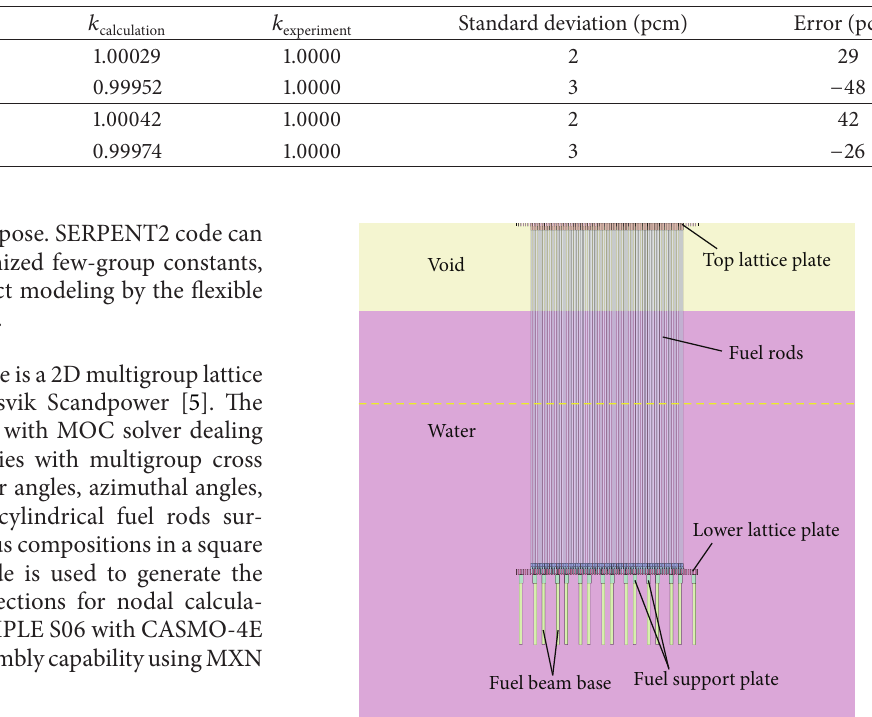
Table 1: The eigenvalue of DIMPLE S06 criticality benchmark by direct modeling (3D).